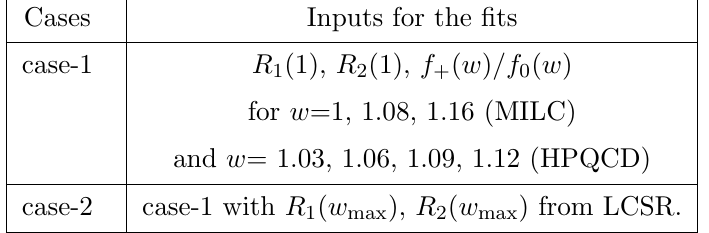
Table 5 . Di(cid:11)erent cases for the (cid:12)t of sub-leading Isgur-Wise